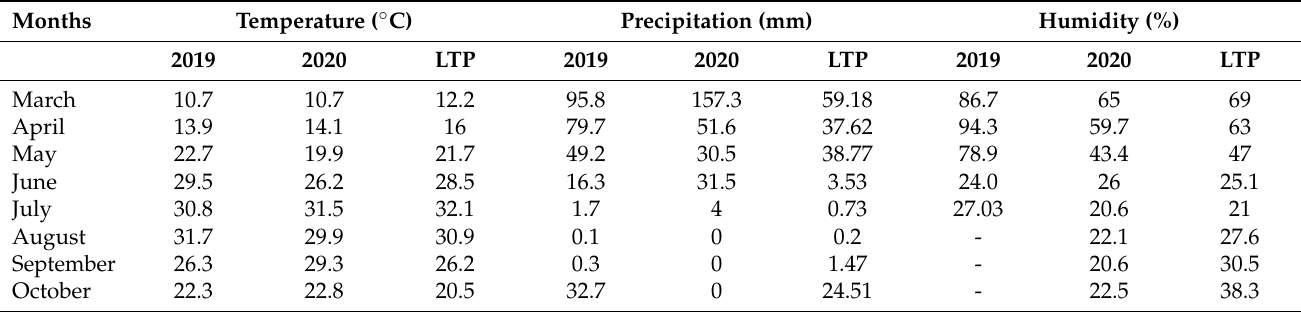
Table 1. The weather conditions of the